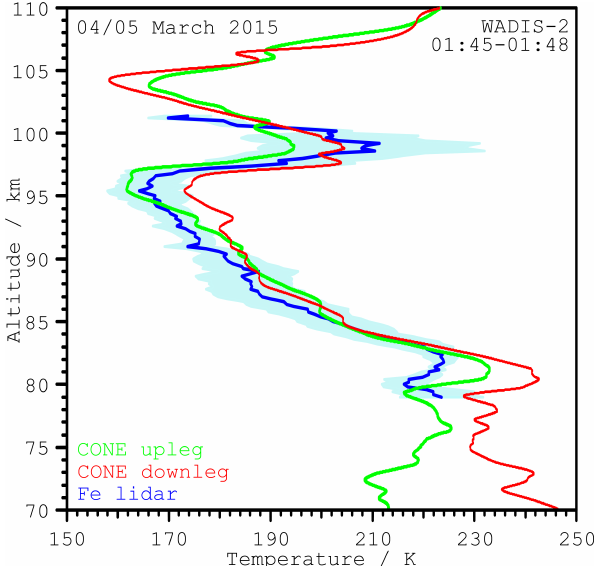
Figure 2. Vertical temperature profiles at the launch time of the WADIS-2 rocket. The red and green curves show the in situ mea- surements with the rocket payload (CONE). The upleg (green) and the downleg (red) profiles are measured with two independent in- struments at the ends of the payload. The Fe lidar (blue) profile is integrated over 60min and centred at 01:45UT. The blue shaded area shows the RMS of all Fe lidar profiles which have their centre within a period of ± 60min around launch time.